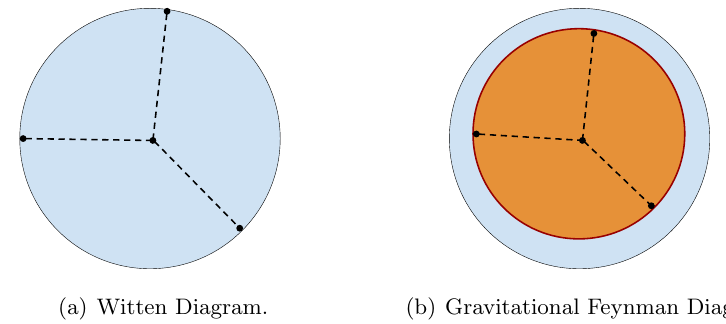
Figure 7 . Summation of 1 e(cid:11)ects (cid:13)uctuates the boundary of Witten N